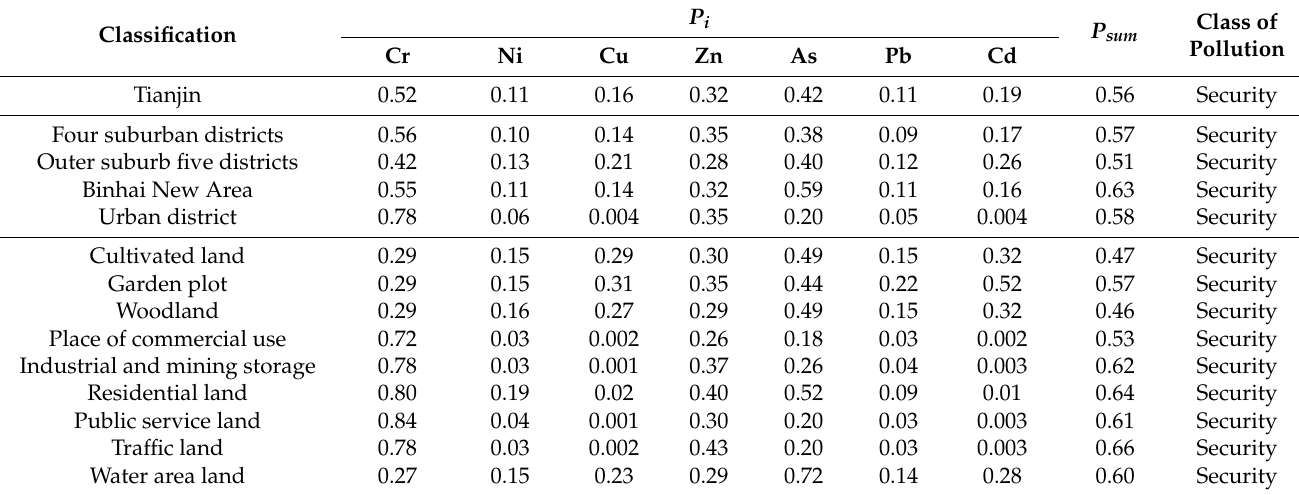
Table 4. Single factor pollution index and comprehensive pollution index of soil heavy